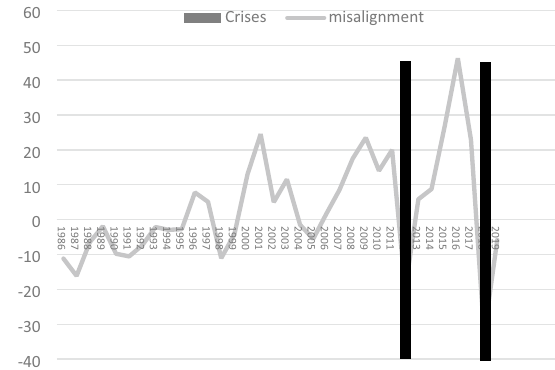
Fig. 3 Exchange rate misalignment and currency crises